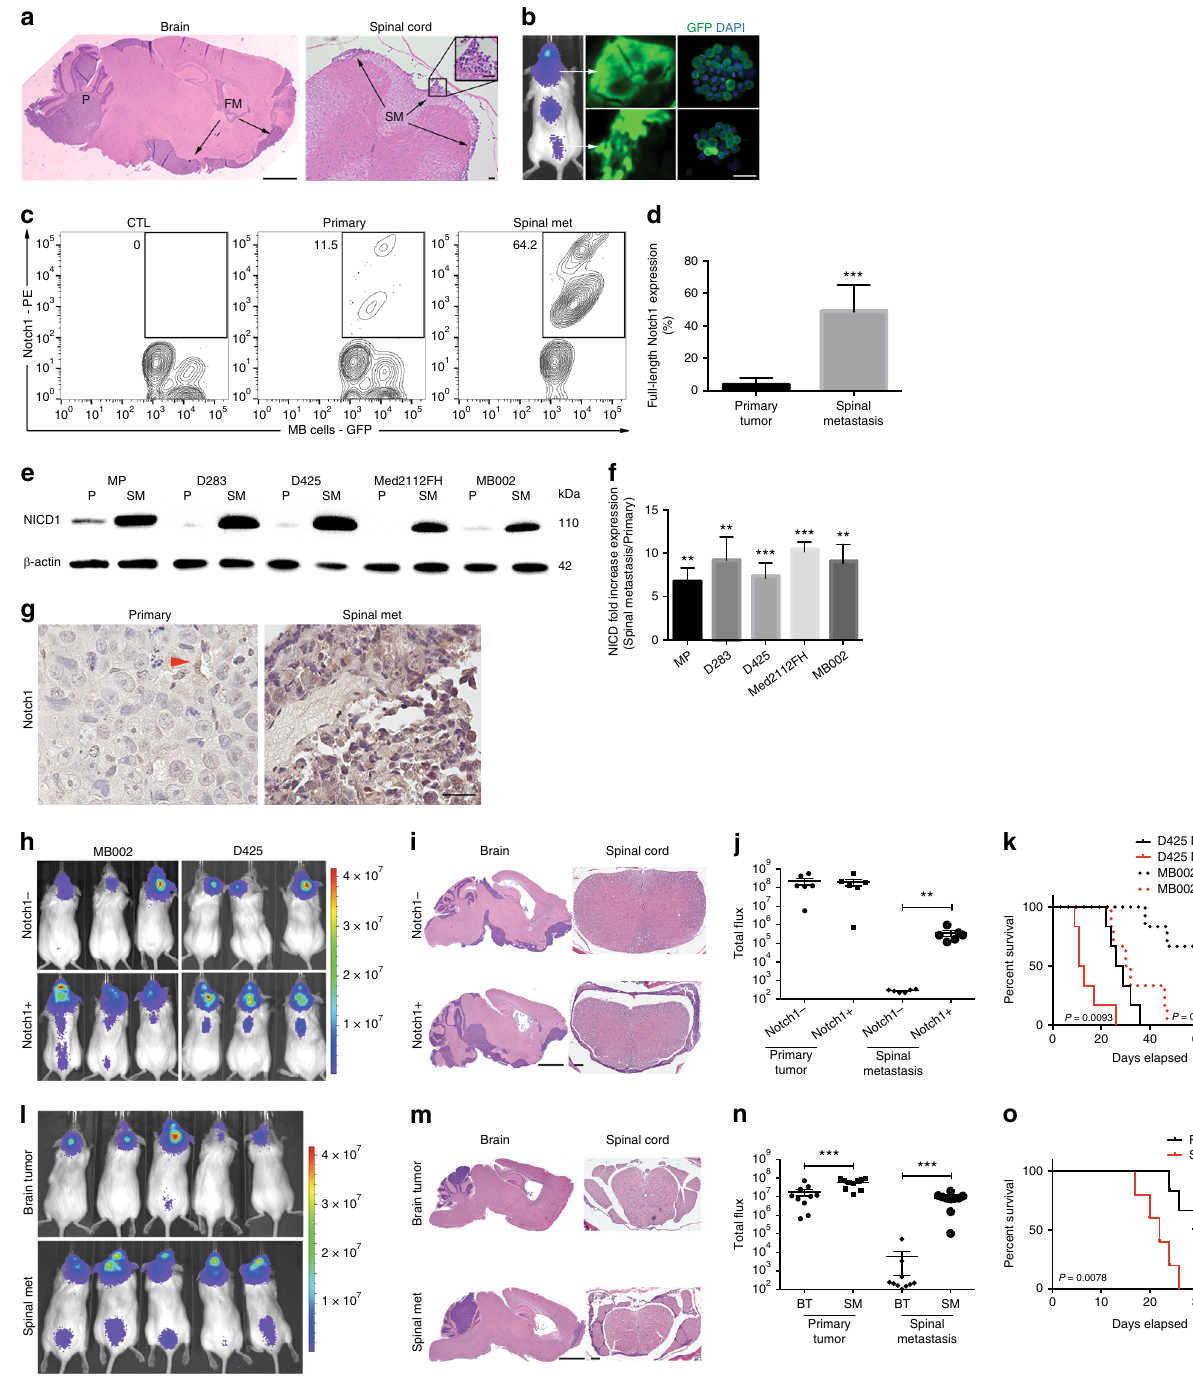
metastases (high frequency of NOTCH1 + cells) and re- transplanted into mouse cerebella. Group 3 medulloblastoma cells isolated from the spinal metastasis generated higher frequency and size of spinal metastases (Fig. 1l – n) and lower survival rate (Fig. 1o) than tumor cells isolated from primary cerebellar tumors. Thus, NOTCH1 + Group 3 medulloblastoma cells exhibit increased invasive and metastatic properties than NOTCH1 − cells, supporting the hypothesis that only a pre-existing minor NOTCH1 + subclone of the primary tumor has the ability to metastasize 4